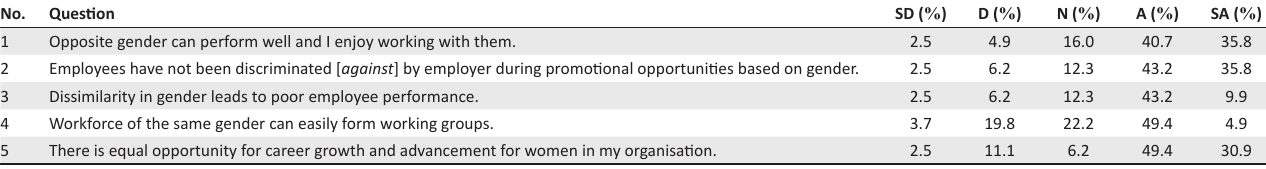
TABLE 4: Central tendencies measurement: Gender diversity.